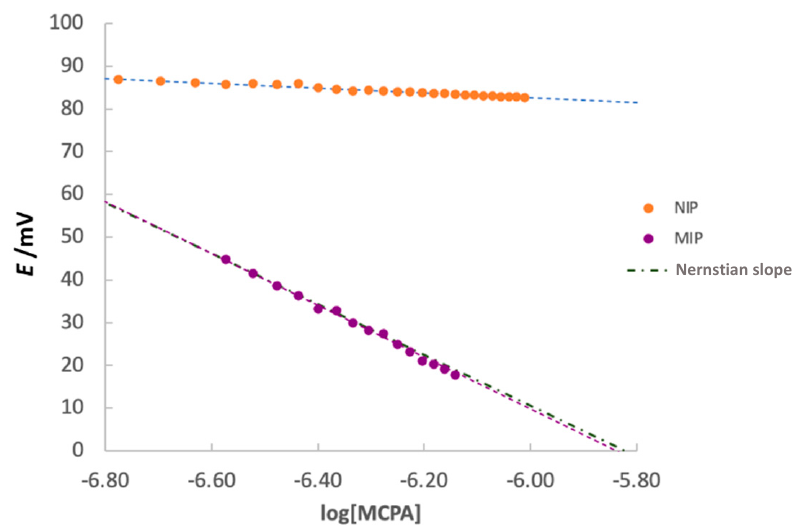
Figure 5. Calibration curve of MCPA of screen-printed cell modified with MIP (purple), with NIP (orange), and theoretical Nernstian slope. Experimental conditions: 15 mL PBS pH 5.5, additions of 0.02 mL MCPA std 25 μ mol L − 1 .